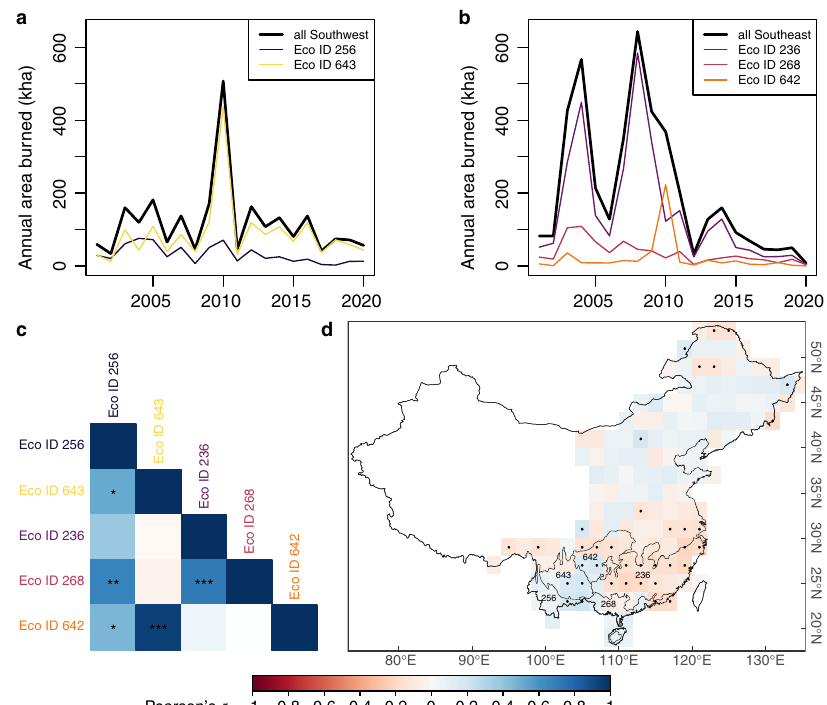
Fig. 2 | There is no dipole in the pattern of burned area between eastern and western tropical forests in China. We examined annual patterns of annual area burned in a southwest China and its ecoregions, and in b southeast China and its ecoregions. c Pearson correlations in annual burned area across ecoregions (one, two or three asterisks indicate signi fi cant correlations at P <0.05, <0.01 and <0.0001 respectively) were positive within eastern and within westernecoregions, and either positive or not-signi fi cant across eastern and western ecoregions. d We